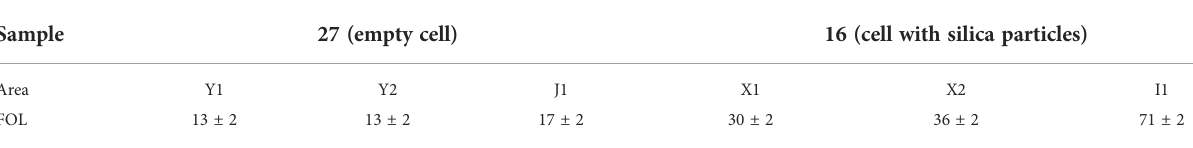
TABLE 1 Statistical analysis of FOL on samples at various areas marked by white-dashed boxes. Sample 27 (empty cell) 16 (cell with silica particles) Area Y1 Y2 J1 X1 I1 FOL 71 ± 2 FOL, frequency of occurrence of